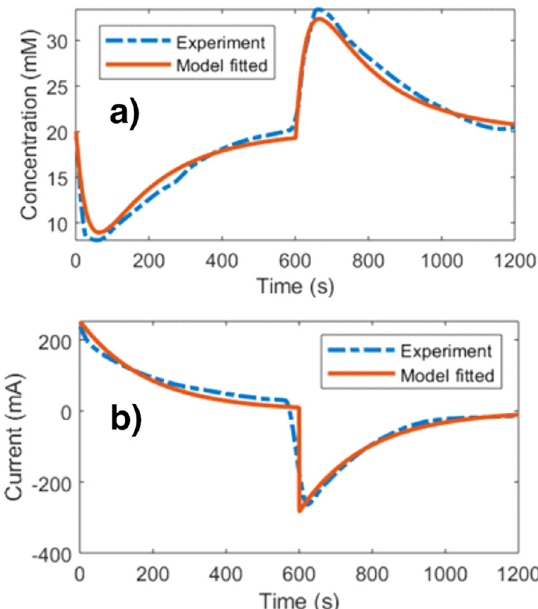
Fig. 3 The performance over time for an MCDI cell in CV mode. This MCDI operation is based on data from ref. 48 . The model fi tting was based on Eq. 11, with a CV voltage of 1.2 V and a constant 20 mM in fl uent ion concentration, whereas the ef fl uent concentra- tion and the current were the outputs. The graphs show experimental data and model fi t for a the cell ef fl uent concentration and b the current through the device.